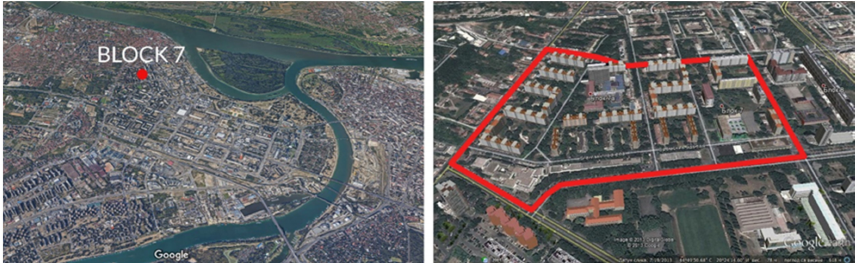
Figure 1. Location of Block 7_ position within New Belgrade (left) and overview (right) ( Google earth